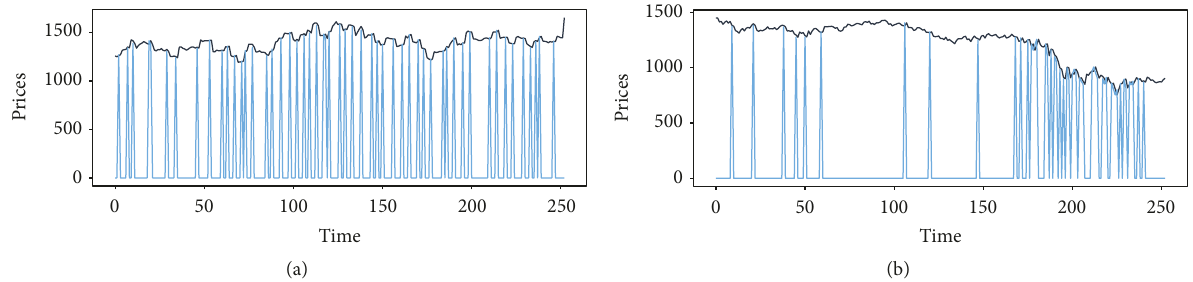
Figure 1: Simulated process 𝜆 = 0.2 (a) and empirical jumps of 2008 S&P 500 prices (b).